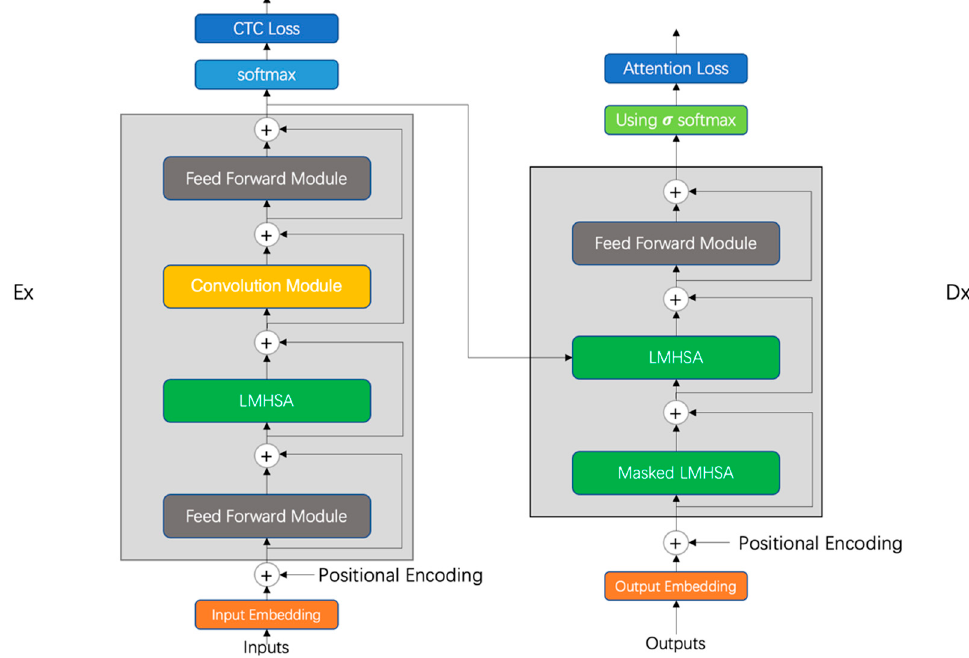
Figure 3. Illustration of our end-to-end Conformer framework graph using low-rank approximate decomposition and balanced softmax.